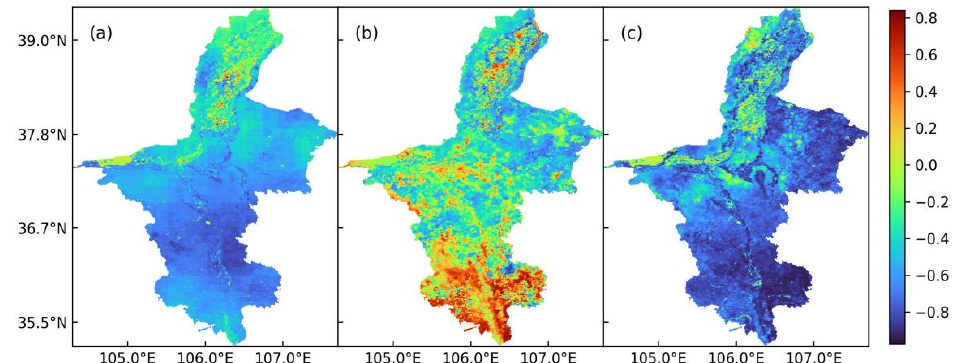
Figure 11. Spatial distribution patterns of the correlation coefficients between EDI and three influ- encing factors in Ningxia from 2001 to 2020. ( a – c ) Spatial distribution of the correlation coefficient between EDI and precipitation ( a ), surface temperature ( b ) and NDVI ( c ).